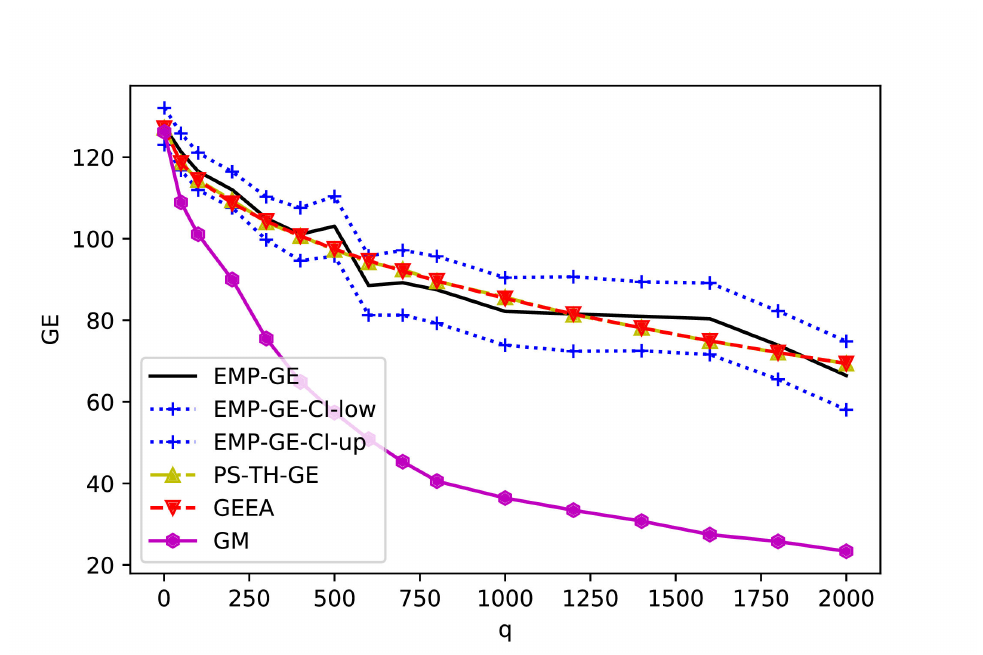
Figure 1: Comparison of four one-byte GE estimations (namely EMP-GE, PS-TH-GE, GEEA, and GM) of the template attack on SGII-1M data set. We also plot the 95% confidence intervals for EMP-GE, whose upper bound and lower bound are labeled respectively by EMP-GE-CI-up and